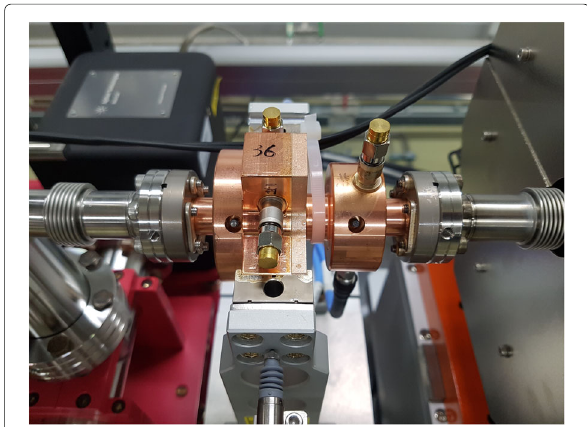
Fig. 8 The cavity BPM in the PAL-XFEL undulator